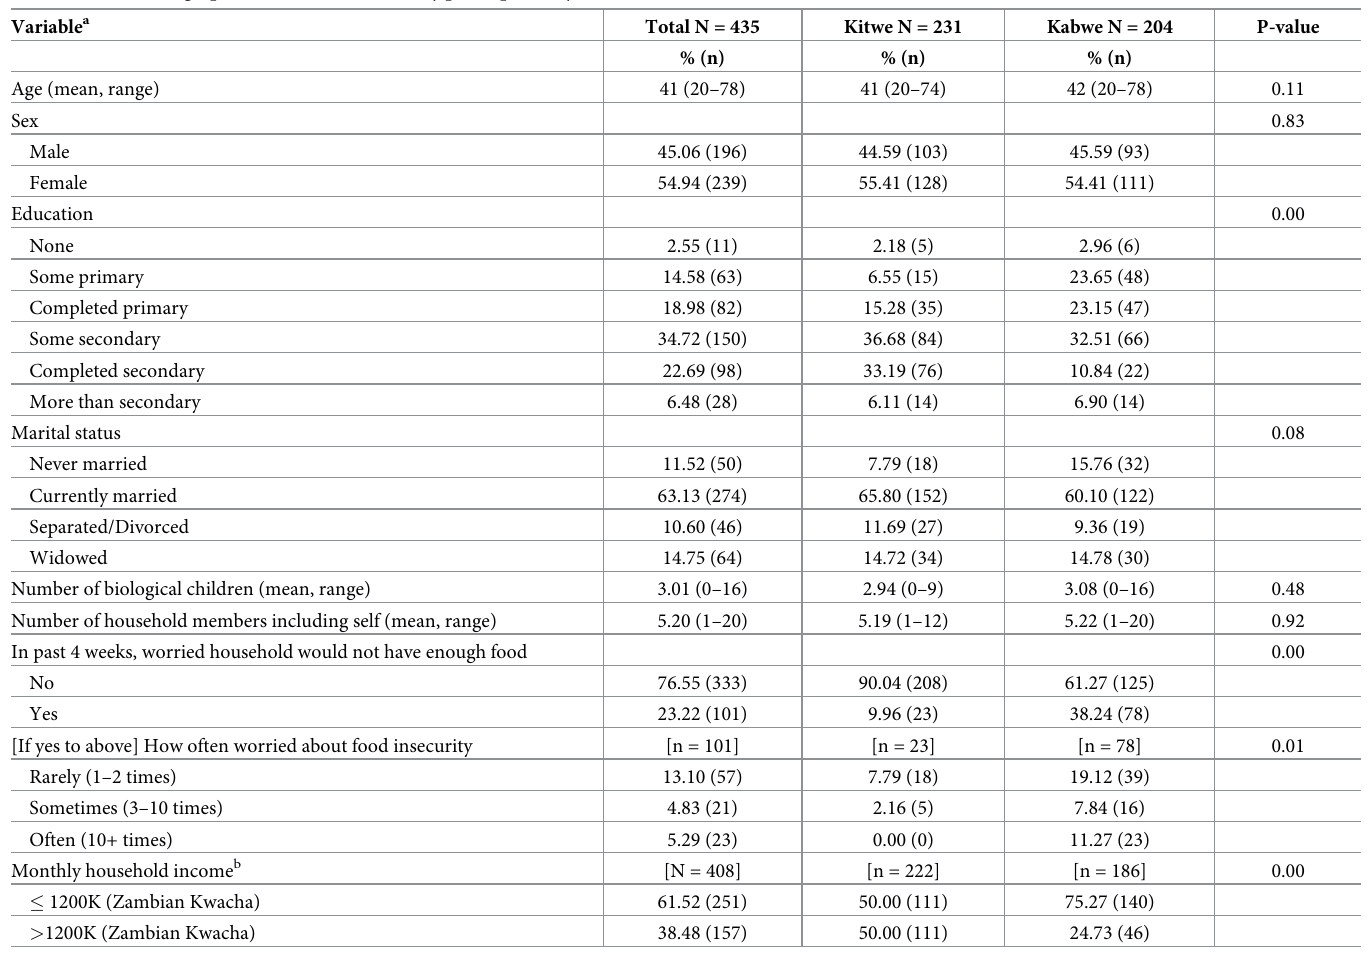
Table 1. Socio-demographic characteristics of study participants, by